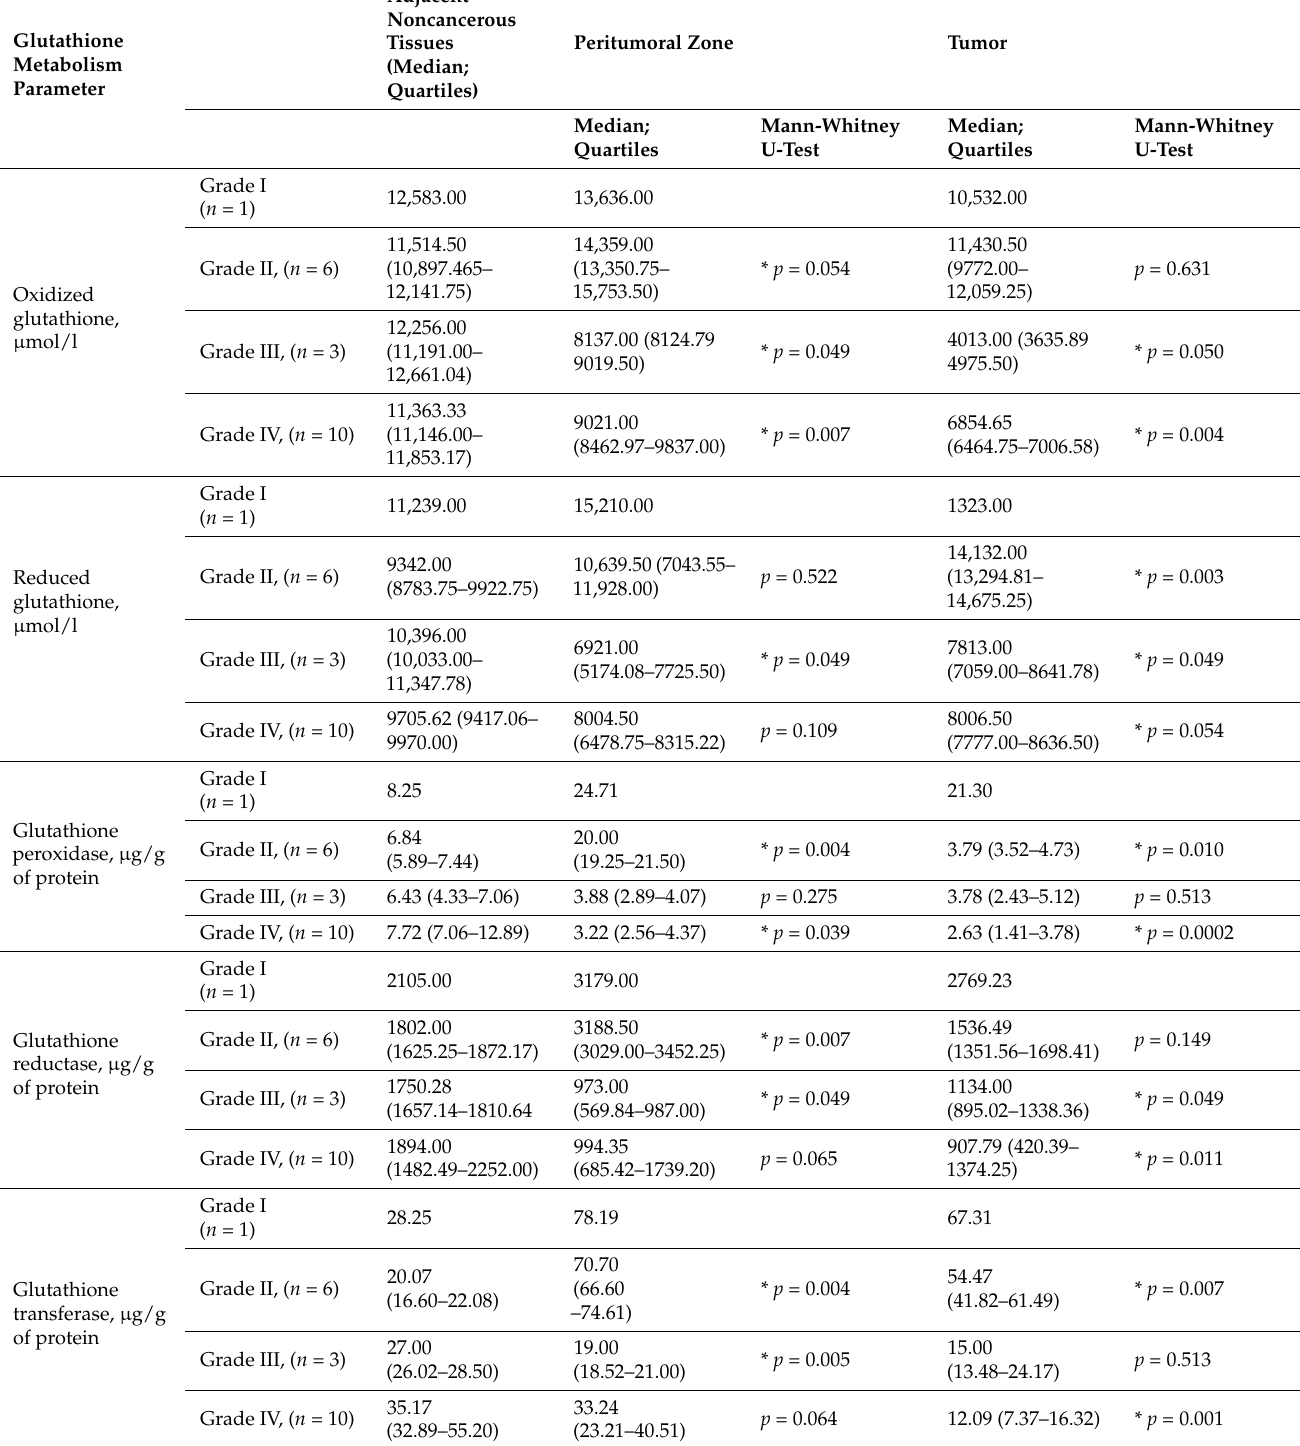
Legend: *—statistically significant differences in comparison with adjacent noncancerous brain tissues. The level of oxidized glutathione was significantly reduced compared to that in the adjacent noncancerous tissues both in the peritumoral zone and in the tumor tissue at all anaplasia grades, except for the tumor tissue at Grade II (Table